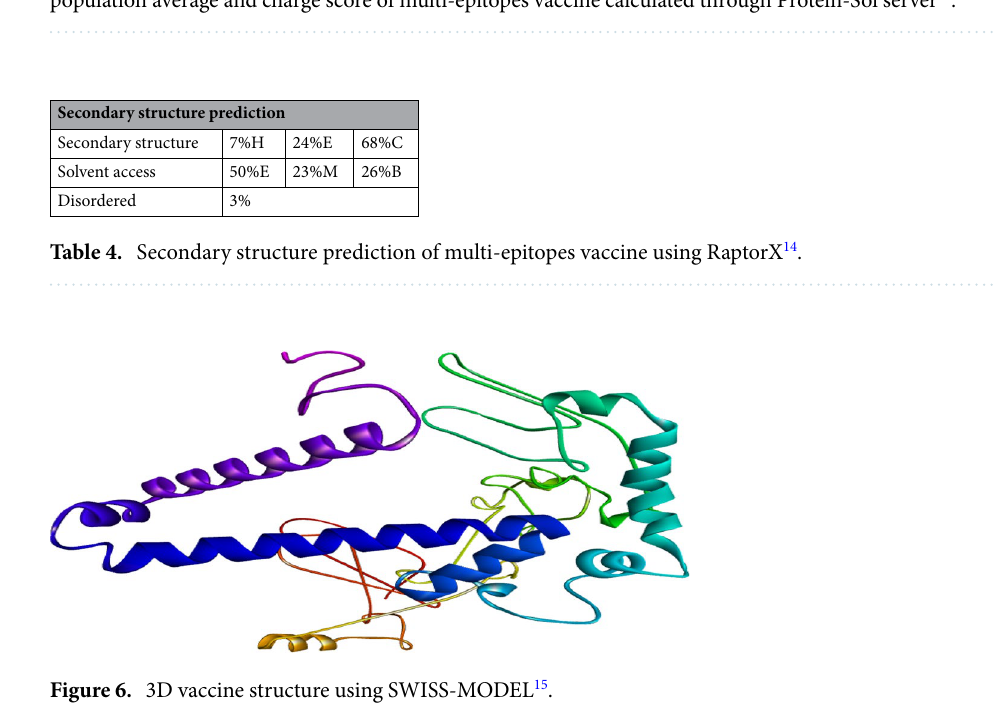
Figure 5. ( a ) Solubility rate of multi-epitopes vaccine calculated through Protein-Sol server. ( b ) Deviation from population average and charge score of multi-epitopes vaccine calculated through Protein-Sol server 23 .